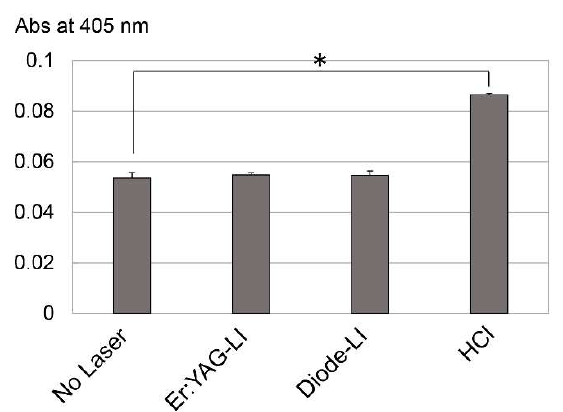
Figure 7. In vitro activation of latent TGF- β 1 by Er:YAG-LI and diode-LI. ALP-inducing activity of HPDL cells after 3 of exposure to Er:YAG laser (Er:YAG-LI), diode laser (Diode-LI), and HCl treatment (HCl) ( n = 6). No Laser: control without LI. Values are the mean ± standard error (* p < 0.05, Steel’s test).